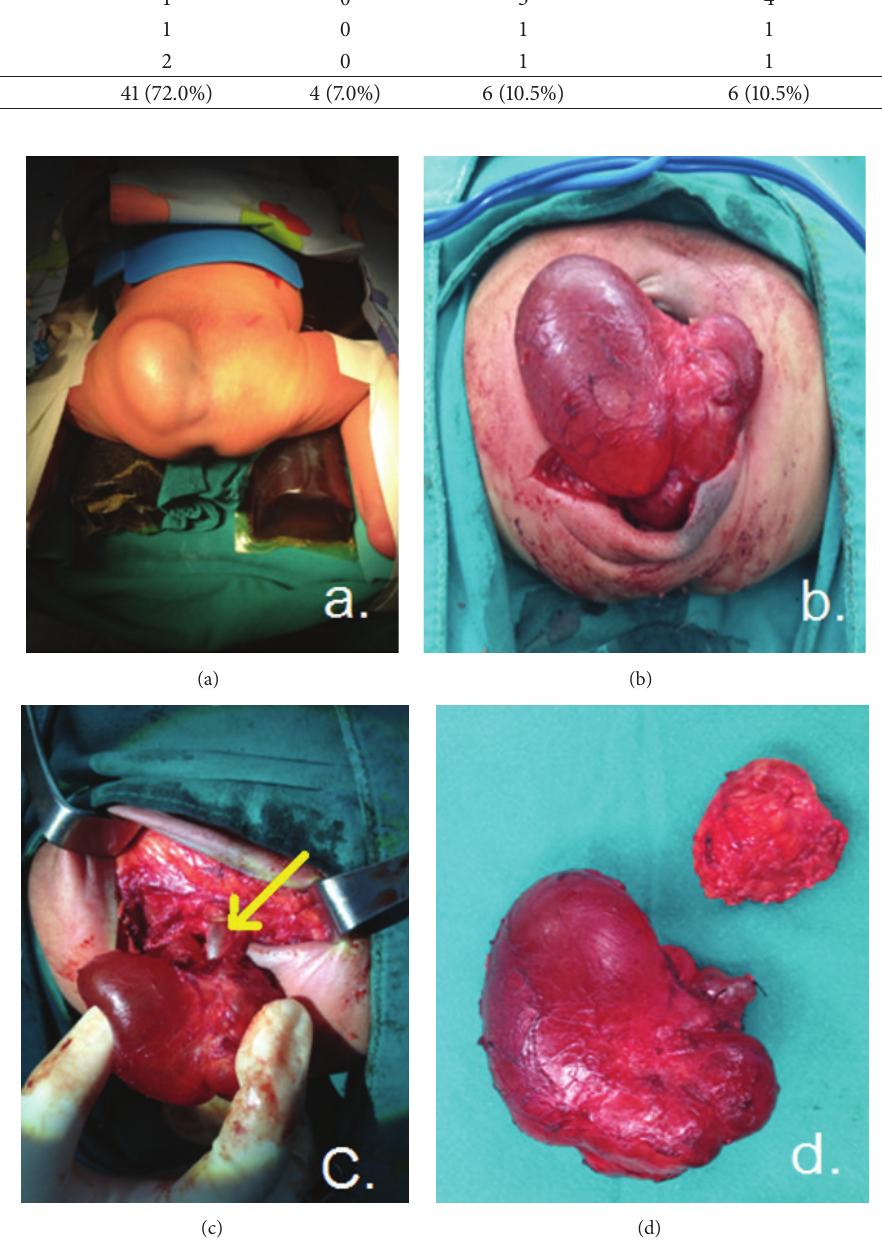
Figure 3: Resection of a type I sacrococcygeal teratoma; (a) the patient in frog-legged position (b) mobilization of the tumor, (c) exposure of the coccyx, and (d) removal of the tumor and